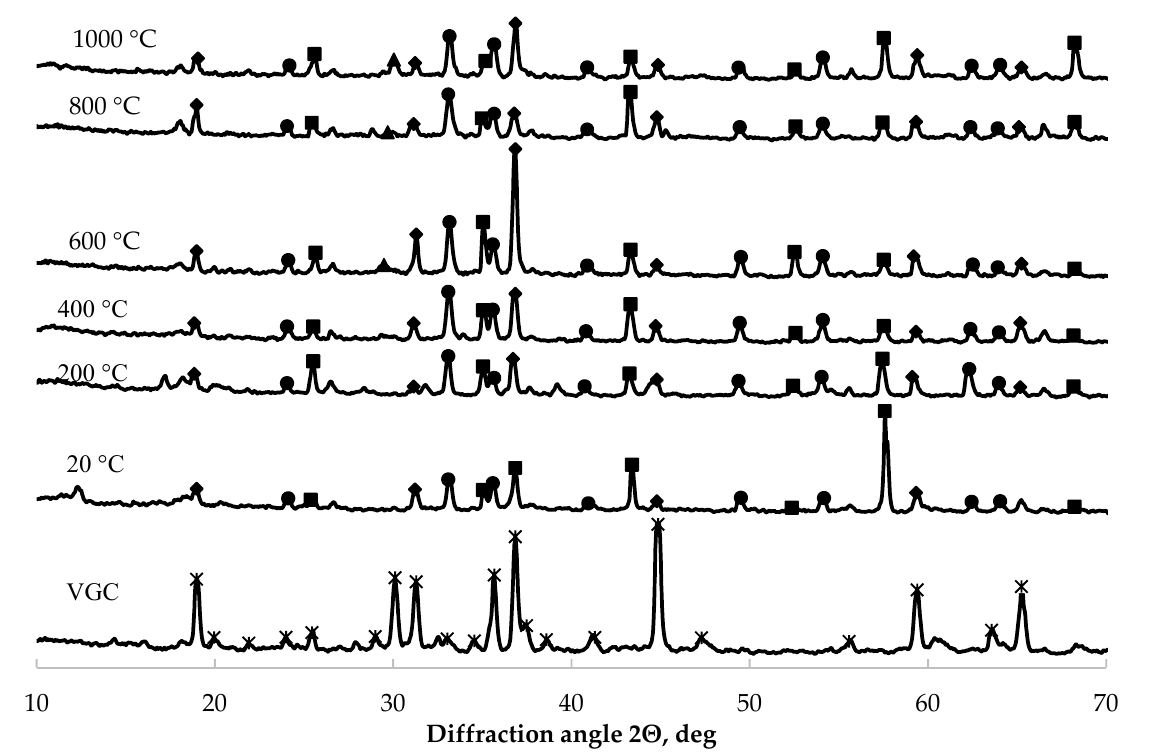
Figure 12. X-ray di ff raction pa tt ern of HACkf concrete specimens before and after heat treatment: ■ Figure 12. X-ray diffraction pattern of HACkf concrete specimens before and after heat treatment: = Al 2 O 3 ; ◊ = spinel; ● = Fe 2 O 3 ; ▲ = CaAl 2 O 4 ; * = VGC. (cid:4) = Al (cid:7) = spinel; • = Fe (cid:78) = CaAl 2 O 3 ; 2 O 3 ; 2 O 4 ; Ж =